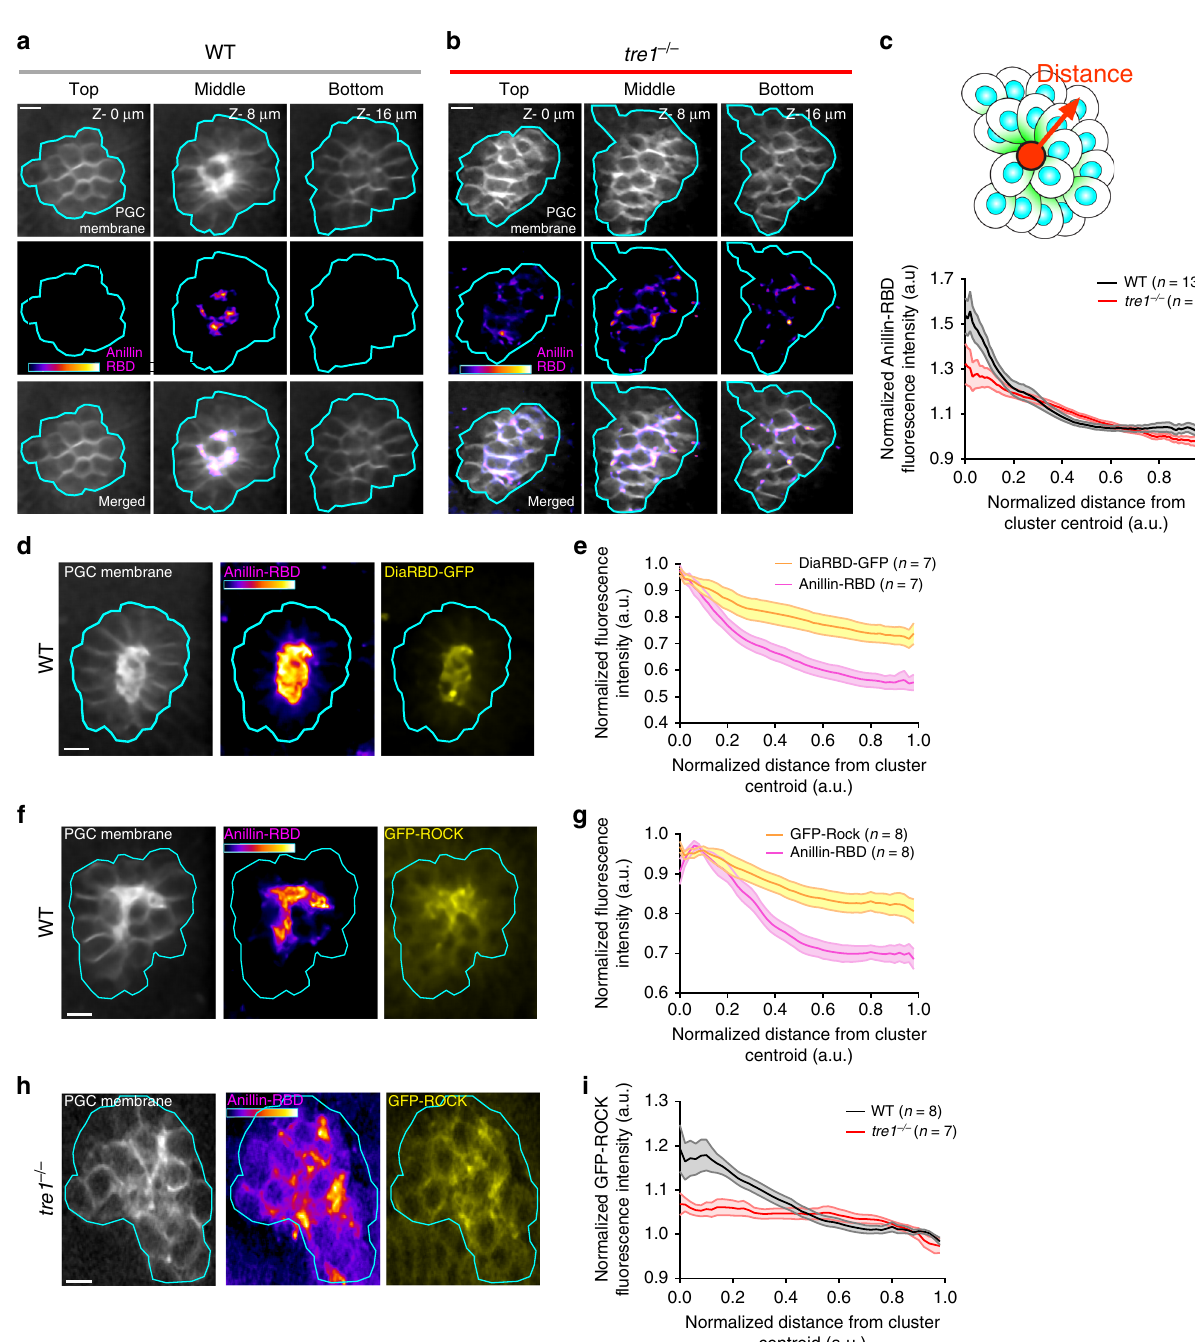
Fig. 2 The RhoA signaling pathway is active at sites of PGC separation. Two photon imaging of a representative WT ( a ) or tre1 − / − ( b ) PGC cluster expressing Anillin-RBD. Three different Z slices at the indicated depth relative to the fi rst slice are shown. The Anillin-RBD is pseudocolored with the color bar within the image (intensity range: 664 – 2175 in ( a , b ). Representative images are from n = 16 embryos in ( a ) and n = 14 embryos in ( b ). c Quanti fi cation of normalized Anillin-RBD intensity relative to distance from the cluster centroid in WT and tre1 − / − PGC clusters. Number of clusters are indicated. Shaded region represents SEM. Two photon imaging of a single Z slice from a representative WT PGC cluster expressing the Anillin-RBD and Dia-RhoA-GTP Binding Domain (RBD)-GFP ( d ) or GFP-ROCK ( f ). The Anillin-RBD is pseudocolored with the color bar within the image (intensity ranges-